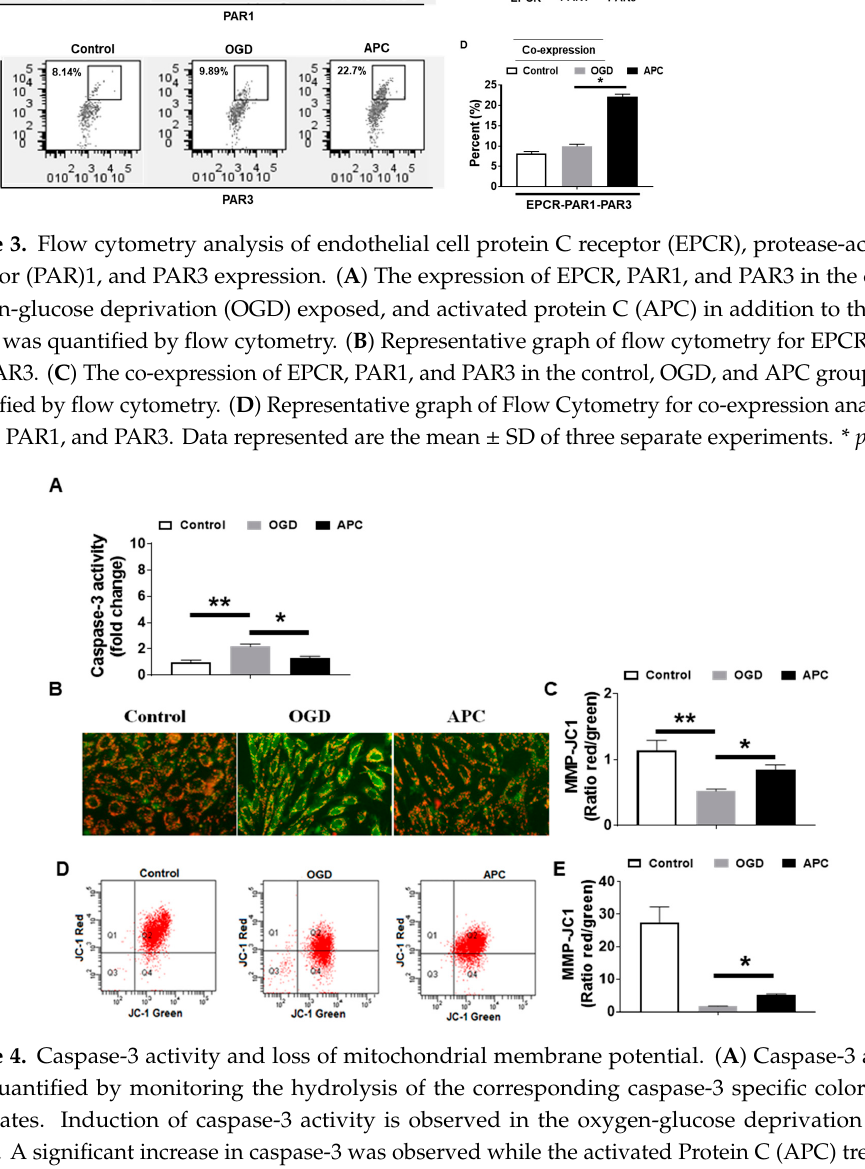
captured after 24 h (h) following OGD with and without APC (100 nM) stained with JC-1 and observed using fluorescent microscopy. ( C ) Graph showing the ratio of the intensity of red to green fluorescence (JC-1 aggregate and JC-1 monomer). ( D ) Loss of mitochondrial membrane potential was detected by flow cytometry. ( E ) Graph showing the ratio of the intensity of red to green fluorescence (JC-1 aggregate and JC-1 monomer) of flow cytometry. Data represented are the mean ± SD of 4 separate experiments. * p ≤ 0.05, ** p ≤